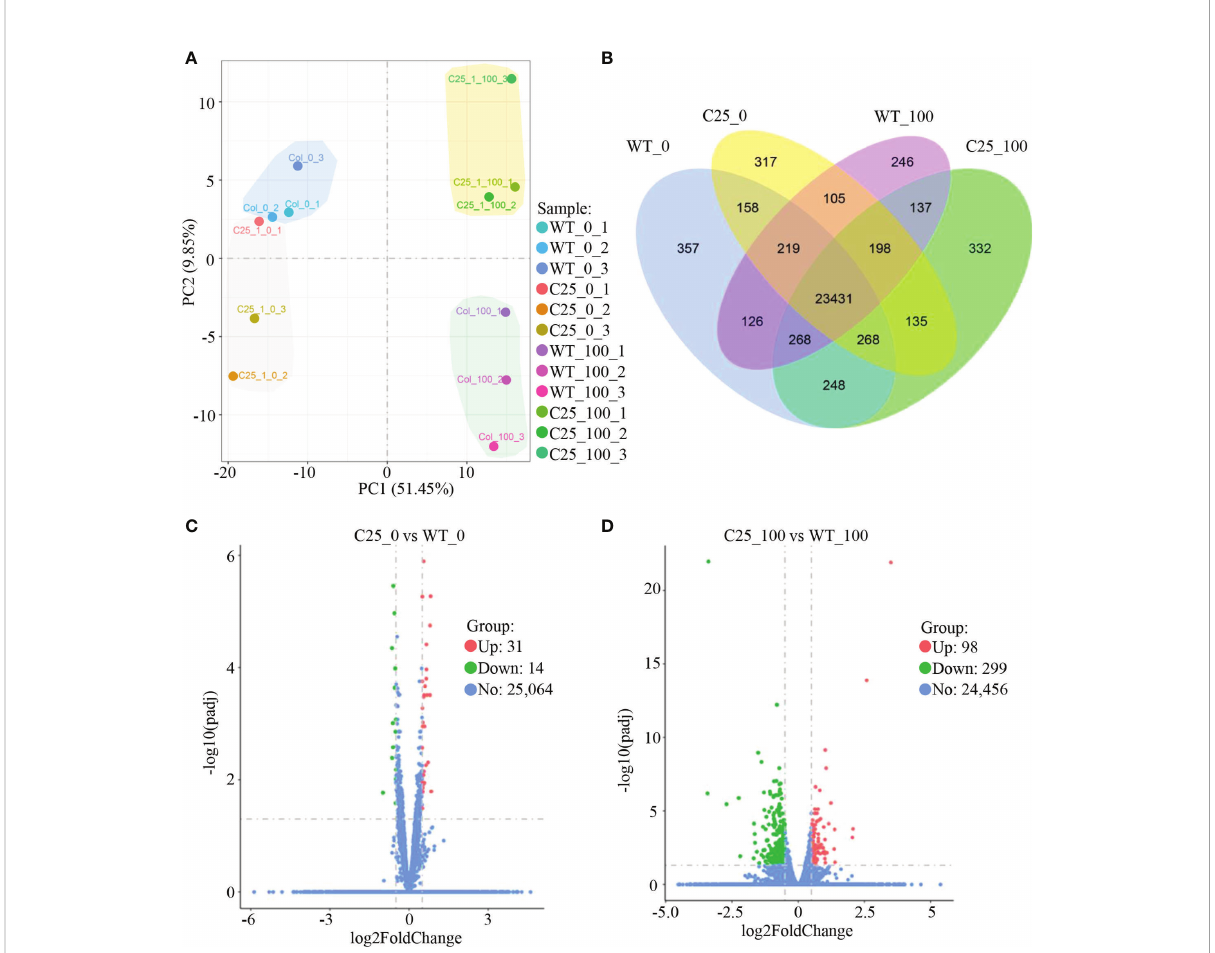
FIGURE 4 NbCIPK25 induces differential expression of genes under salt stress. (A) PCA analysis of the allele expression in wild type (showing as WT) and transgenic seedlings (showing as C25) under 0 or 100 mM NaCl treatment with ggplot2 in R (Version 3.0.3). WT_0 and C25_0 means no salt treatment, WT_100 and C25_100 represent plants treated with 100 mM NaCl. (B) Venn diagram of expressed genes in the genotypes as indicated. Blue shading means genes expressed in WT under normal condition; yellow shading represents genes expressed in transgenic plants under normal condition; purple shading indicates genes expressed in WT under 100 mM NaCl treatment; green shading contains genes expressed in transgenic plants under 100 mM NaCl treatment. (C, D) Volcano plots of fold changes of differentially expressed genes (DEGs) from NbCIPK25 overexpressing plants vs WT under the condition with or without salt treatment. Red and green dots represent upregulated and downregulated DEGs, respectively. |Log2Foldchange| >0.5 and adjust p value ( q value) < 0.05 were set as cut-off value to screen DEGs by DESeq2 with R package. “ 31 ” and “ 14 ” in panel C mean the numbers of upregulated and downregulated DEGs from transgenic plants vs WT under normal condition, respectively. “ 98 ” and “ 299 ” mean the numbers of upregulated and downregulated DEGs from transgenic plants vs WT under salt condition,